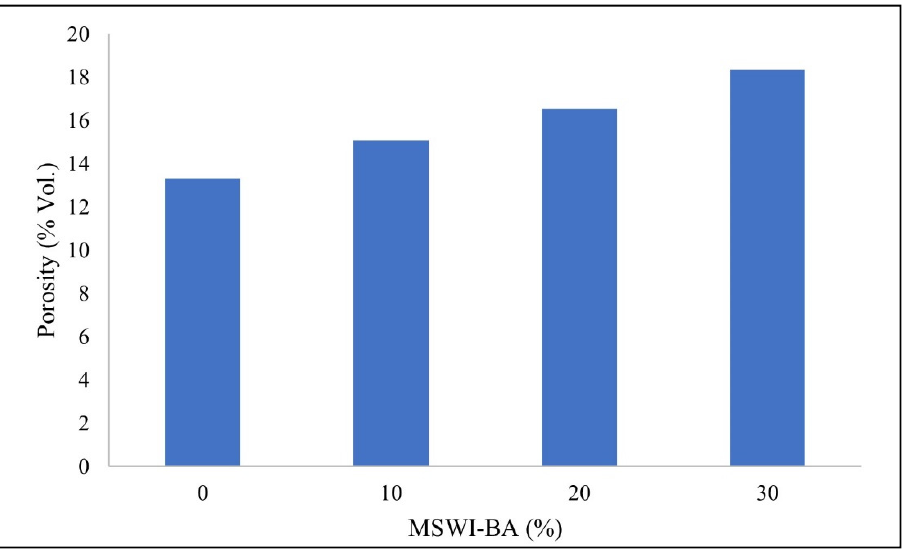
Figure 8. Porosity of concrete containing MSWI-BA, with data from [86].